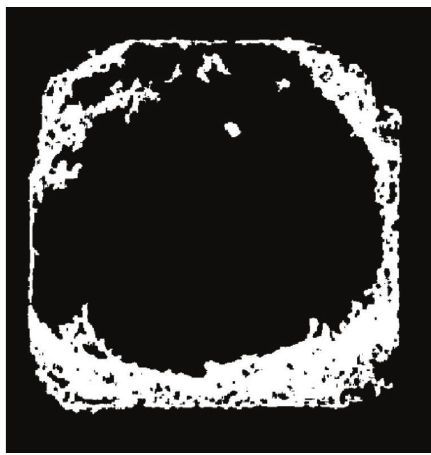
Figure 7: Output after noise removal.